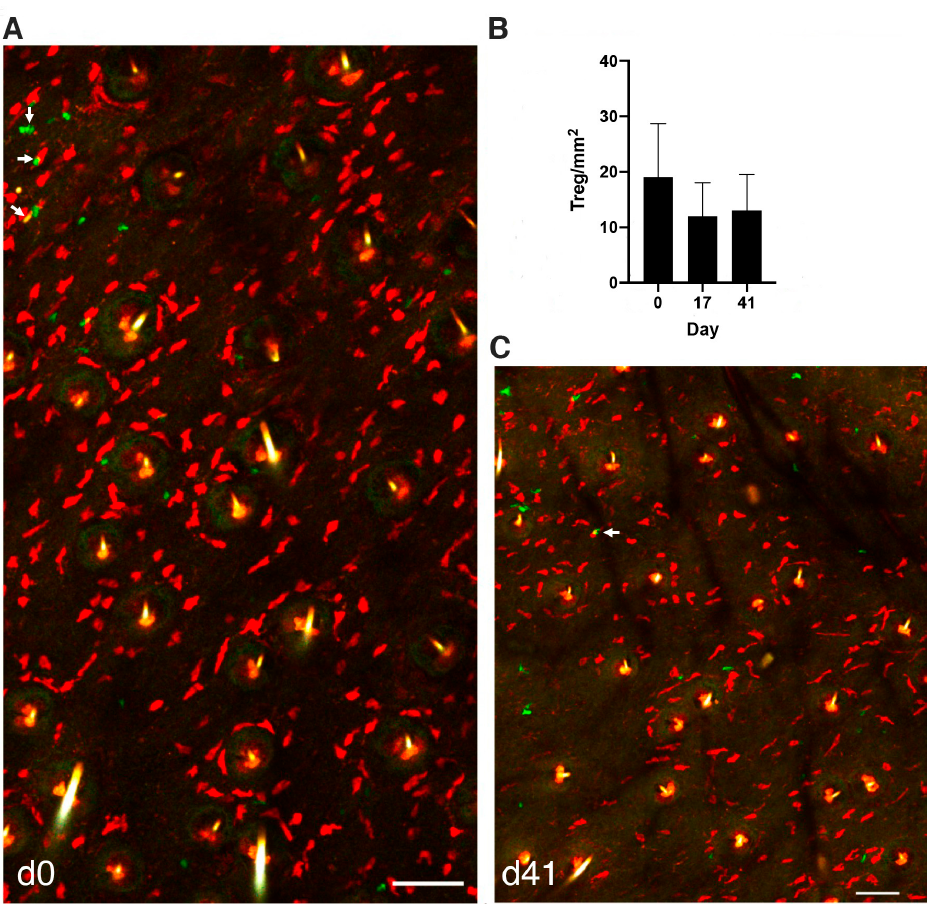
Figure 3. Distribution of Foxp3 + Tregs in the skin is unaffected by conditional ablation of mast cells. ( A ) Dual visualization of Foxp3-eGFP + Tregs and tdT + MCs in the ear skin of RMB-Foxp3-eGFP mouse at steady state before DT injection (d0) on mosaic images of maximum Z projection of 13 sections (Z step size of 1.5 µm). Arrows indicate motile Tregs that are in contact with sessile MCs. ( B ) Quantification of Tregs at steady state and after depletion of MCs at indicated days. Each quantification was performed in at least three independent fields of over 400 × 400 µm Z projection images from two to four mice and are expressed as total numbers of Tregs per mm 2 . ( C ) Dual visualization of Foxp3-eGFP + Tregs and tdT + MCs in the ear skin of RMB-Foxp3-eGFP mice at day 41 (d41) after DT injection on mosaic images of maximum Z projection of 13 sections (Z step size of 1.5 µm). The arrow indicates a motile Treg in contact with a sessile MC. Scale bars ( A,C ) 100 µm.